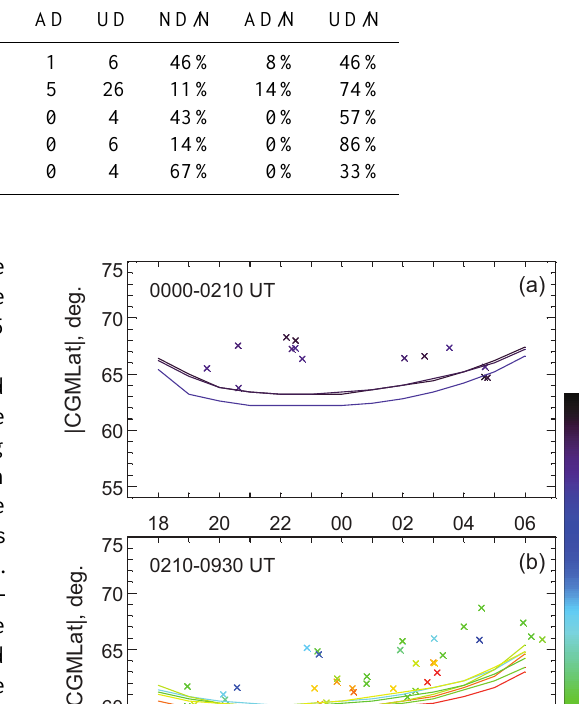
of 0 ◦ and 90 ◦ P2 flux. All profiles correspond to observa- tions in the 17–20.5 MLT sector and plotted chronologically from the top to the bottom. The Universal Time is shown on the left, and the values of Sym-H ∗ are shown on the right. The horizontal axis represents an absolute value of corrected geomagnetic latitude. Spacecraft IDs are shown as vertical axis titles. NOAA-15 and -16 passed the given MLT sector in the Southern Hemisphere, whereas METOP and NOAA- 17 (marked by red color) did in the Northern